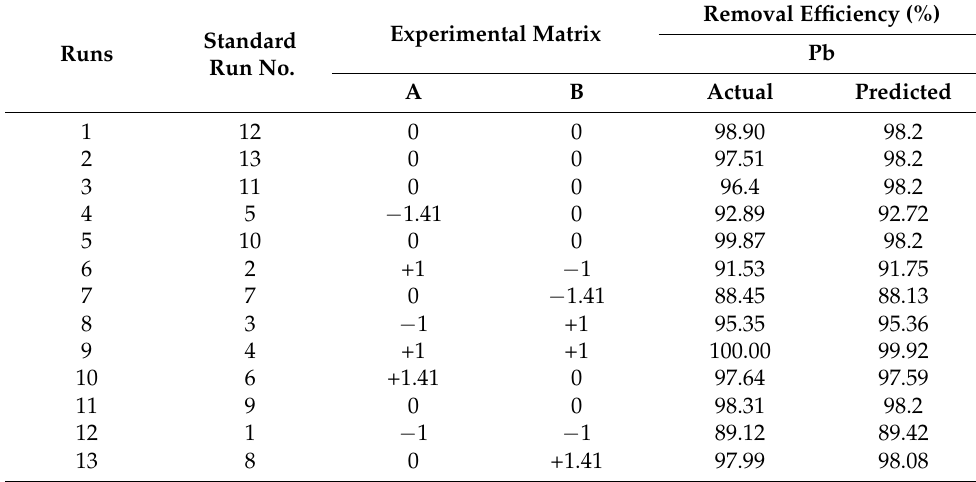
Table 2. Design matrix of experiments and results of CCD. Experimental Matrix Standard Runs Run No.